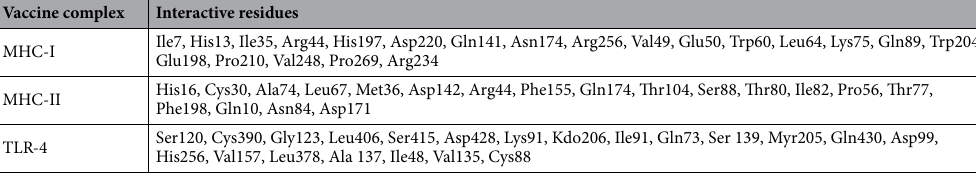
Table 6. Residues interaction of MHC-I MHC-II and TLR-4 with the final vaccine model.